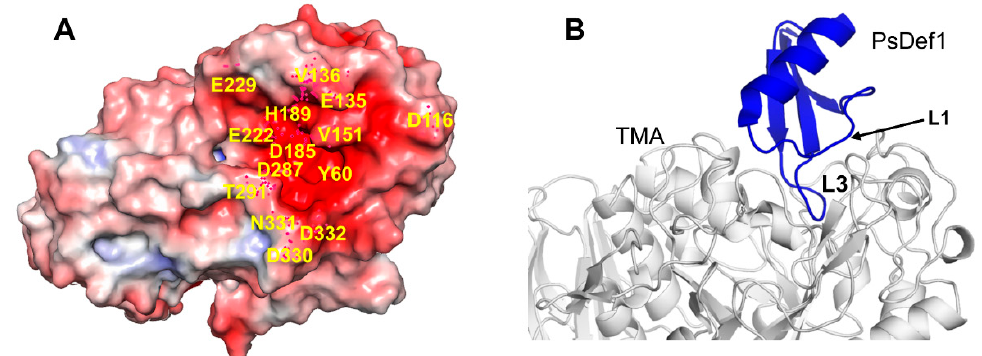
Figure 7. Docked structure of plant defensin PsDef1 and TMA. ( A ) Electrostatic potential is shown on the surface of α -amylase from Tenebrio molitor (mealworm beetle) larvae (TMA) (PDB code 1JAE) [113]. The blue color represents a positive charge, and the red color represents a negative charge. The active site of TMA is highly negatively charged. Residues within and surrounding the catalytic site discussed in the text are labeled on the structure. ( B ) The computationally docked structural model of PsDef1 shows that loop L3 enters the active site of TMA, and loop L1 forms additional contacts supporting the PsDef1-TMA complex. The NMR structure of PsDef1 (PDB code 5NCE) was docked into the X-ray structure of TMA using the ClusPro web server [119]. Protein interactions were evaluated using the PDBsum web server [120].